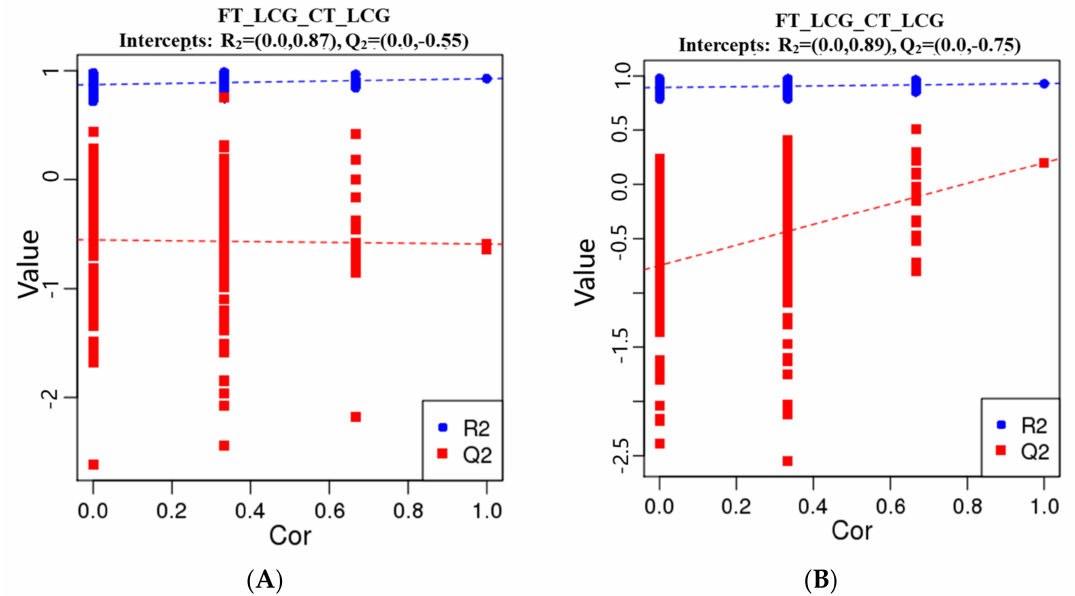
Figure 7. PLS-DA sorting verification diagram (( A ): positive mode; ( B ): negative mode). The scores for R2 and Q2 make up the ordinate, while the abscissa represents the correlation between the original grouping Y and the random grouping